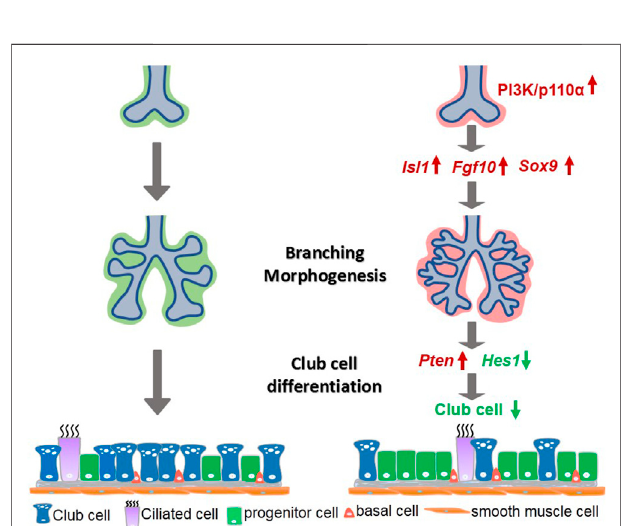
FIGURE 8 | A simpli fi ed model illustrating PI3K/p110 α signaling in mesenchymal lung development. Mesenchymal activation of PI3K/p110 α promoted branching morphogenesis through the Isl1 – Fgf10 – Sox9 pathway, and regulated club cell differentiation by the Pten - Hes1 pathway.